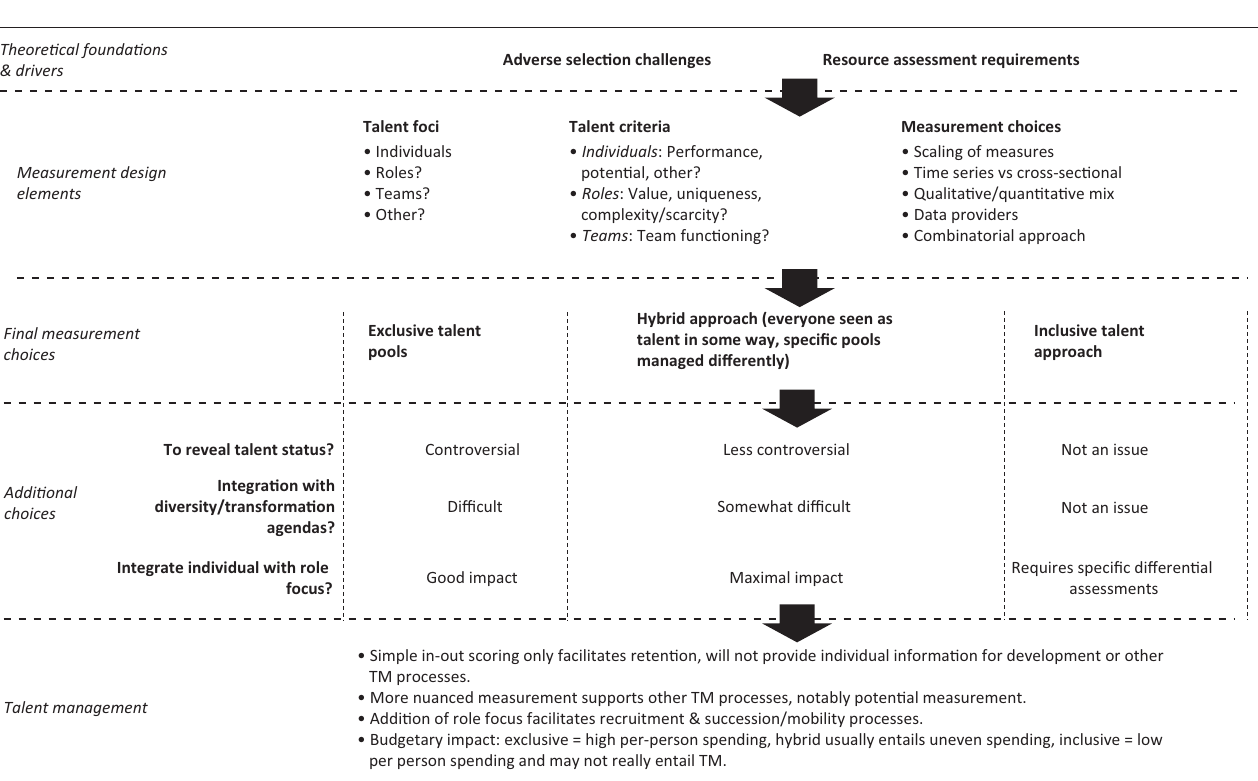
FIGURE 1: A framework of the talent measurement process and